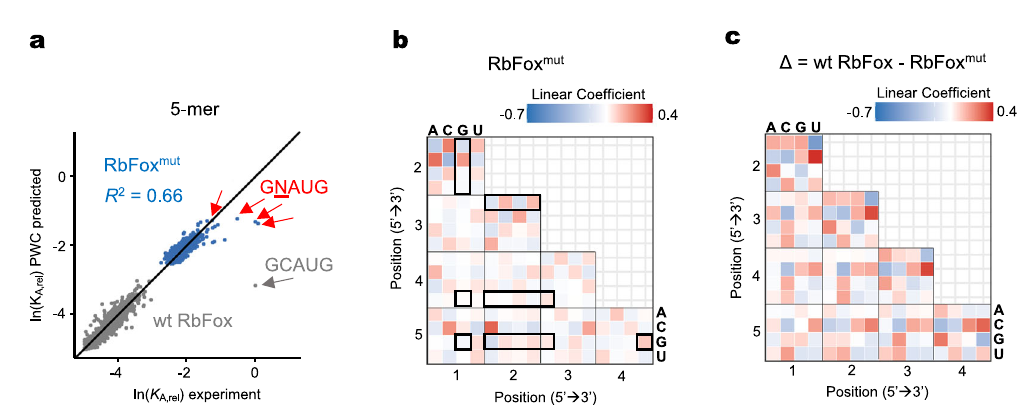
Fig. 4 | Analysis of RbFox mut af fi nity distribution with quantitative binding models. a Correlation between experimental K A,rel values for RbFox mut for each 5-mer (median values, Supplementary Fig. 8) with values calculated with the PWC binding model (blue dots: RbFox mut ; red arrow: consensus 5-mer 5 ’ -GNAUG; line: diagonal, y = x ; R 2 : correlation coef fi cient). The plot for wt RbFox (gray dots) is plotted as reference. b Linear coef fi cients for each pairwise coupling between all